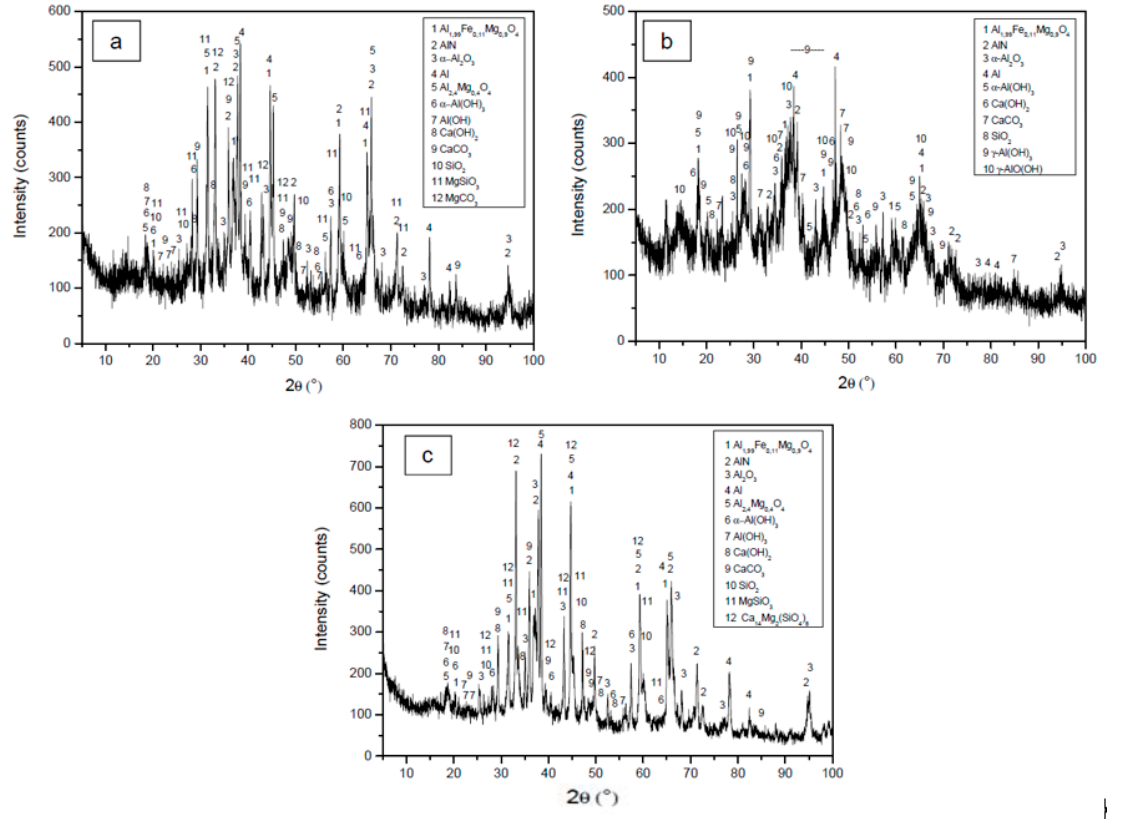
Figure 1. XRD di ff raction pattern of the drosses studied; ( a ) Al-1, ( b ) Al-2, and ( c ) Al-3. Table 2. Mineralogical composition of the aluminum drosses (wt